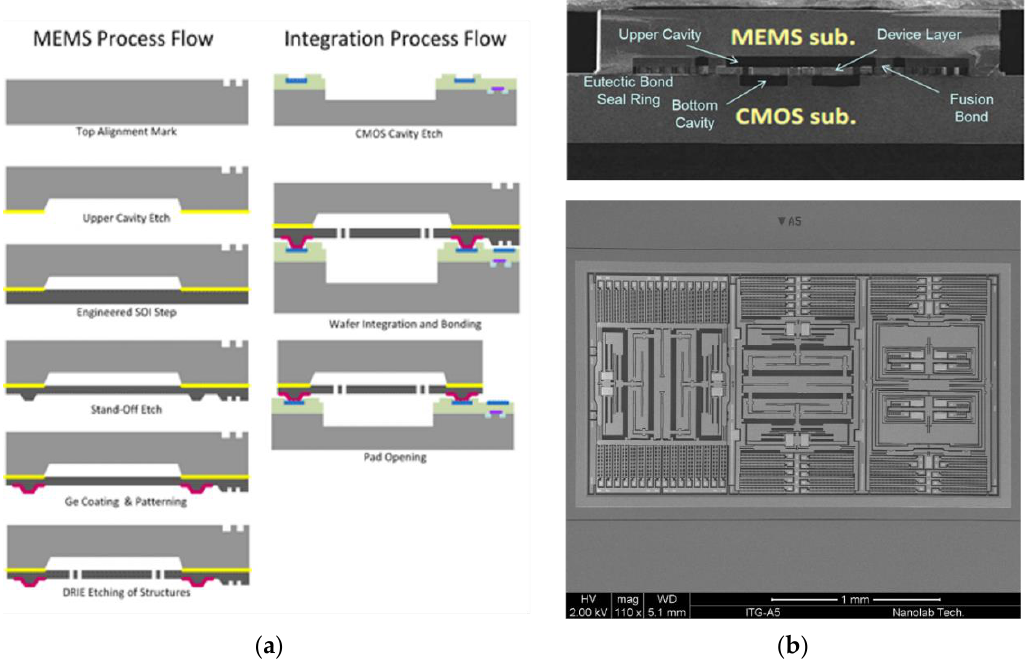
Figure 6. ( a ) Heterogeneous process flow in which germanium (Ge) is deposited on the microelectromechanical (MEMS) wafer and joined to aluminum (Al) bond pads and the seal ring on the complementary metal-oxide semiconductor (CMOS) wafer. The Al 0.72 Ge 0.28 eutectic bond